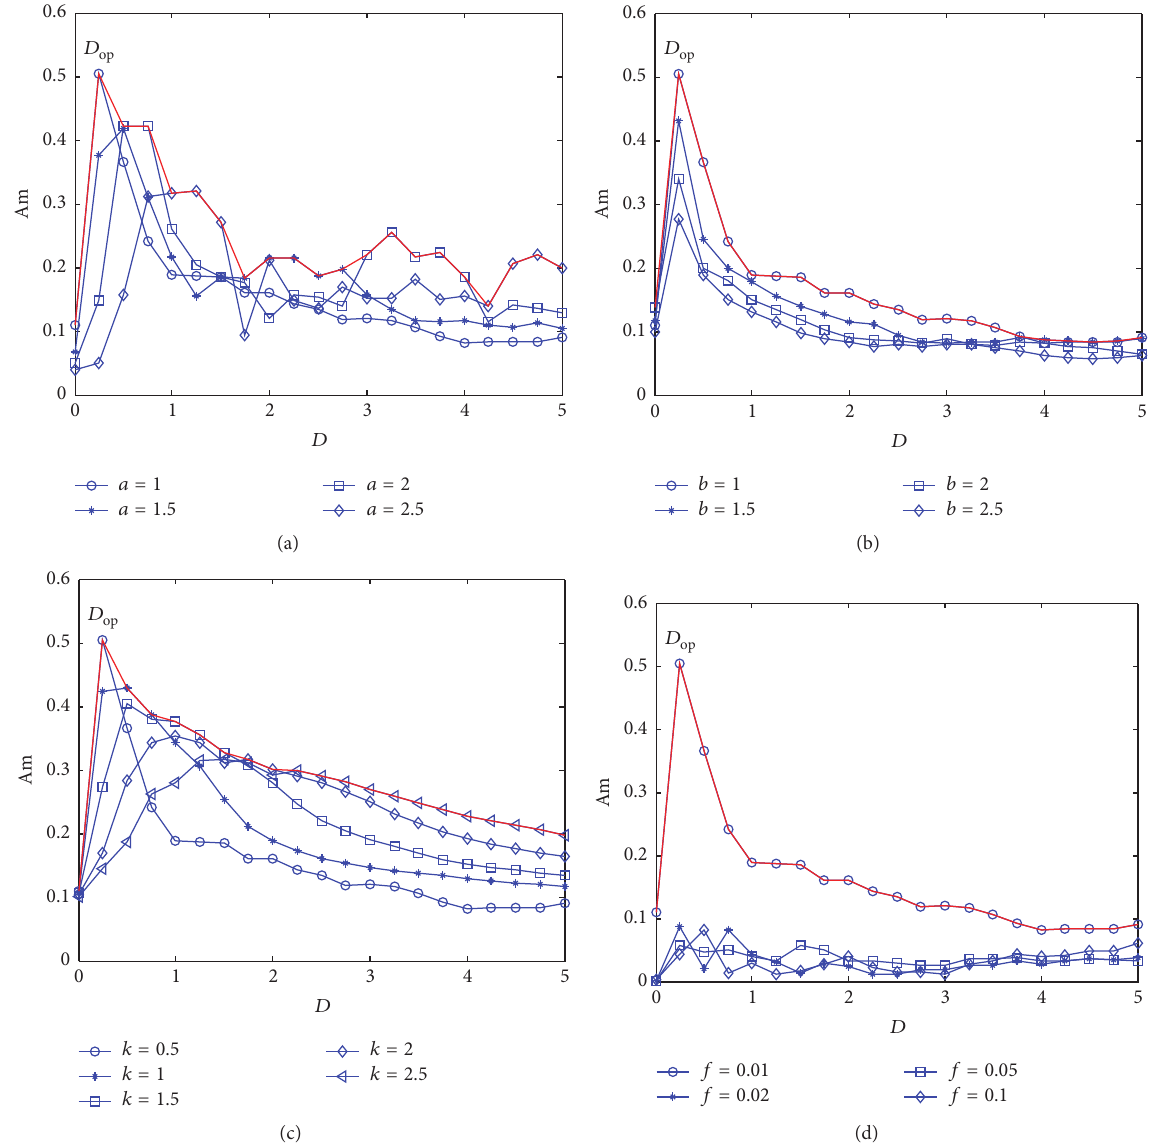
Figure 5: The change curves of Duffing oscillator SR effect versus noise intensity 𝐷 under different conditions. (a) Different parameter 𝑎 , (b) different parameter 𝑏 , (c) different damping ratio 𝑘 , and (d) different signal frequency 𝑓